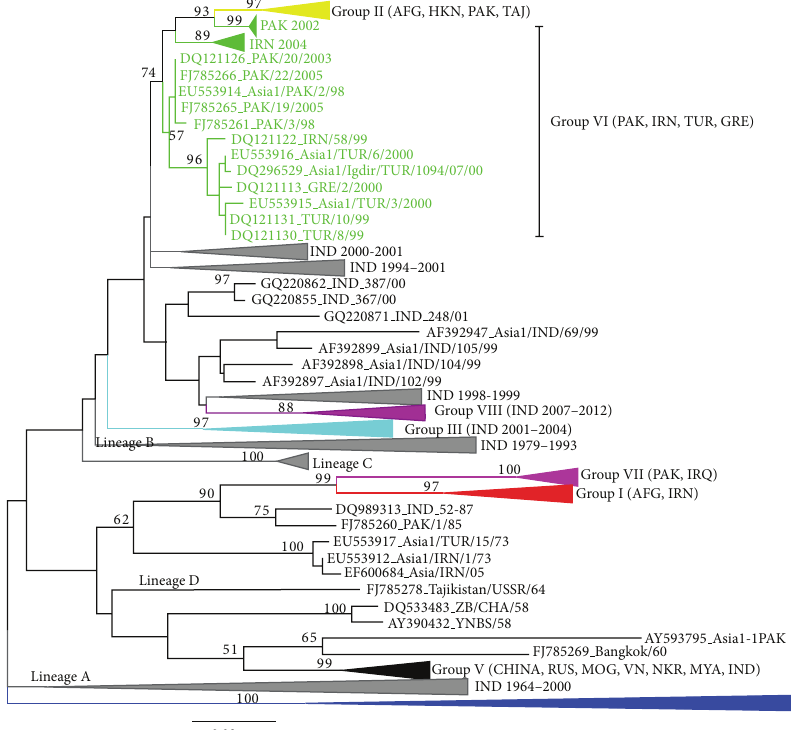
Figure 1: Midpoint-rooted maximum likelihood phylogenetic tree for the nucleotide sequences of the complete VP1 gene of serotype Asia